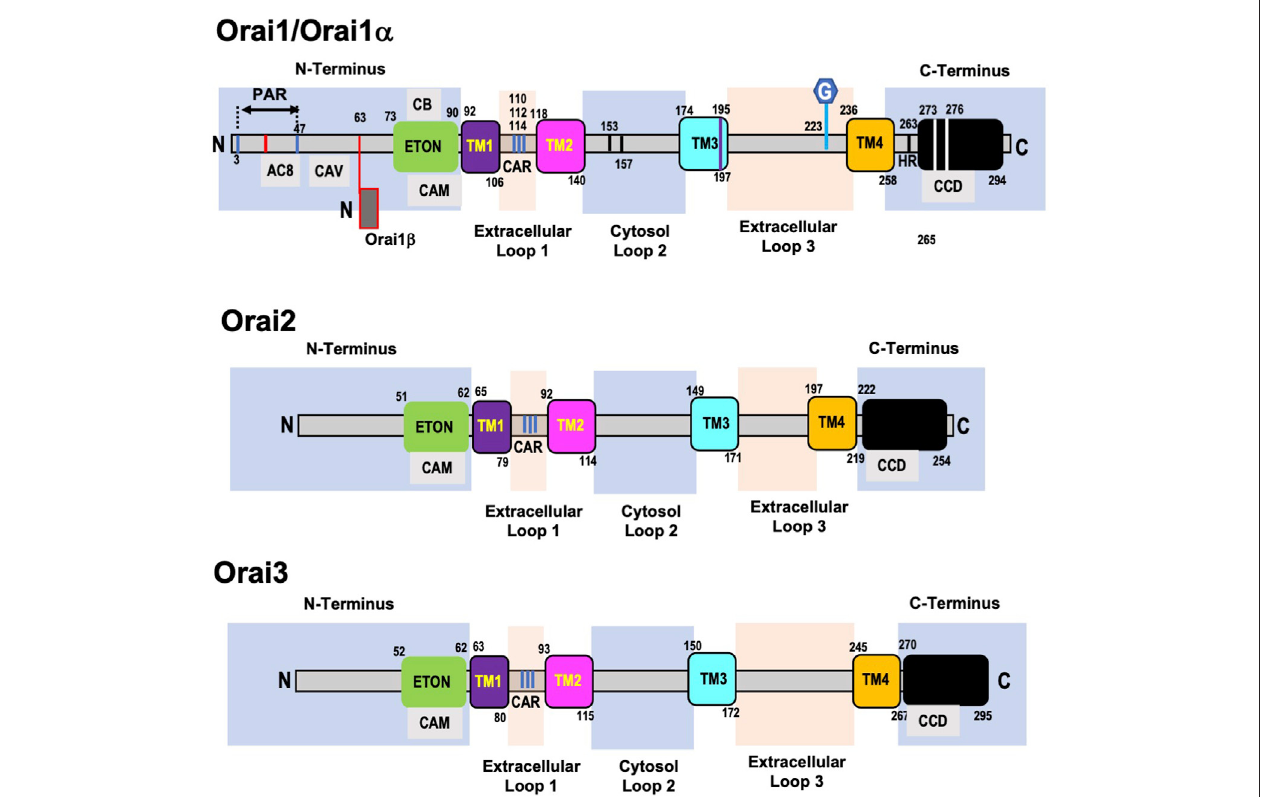
FIGURE 2 | Domain structure of human ORAI1, ORAI2, and ORAI3 proteins. Orai1 (Orai1 α ) has a proline arginine region (PAR) close to the end of the N-terminal domain,whichincludesaninteracting siteforadenylatecyclase-8 (AC8).Thisisfollowedbyacaveolin bindingregion(CAV)andadjacent totheplasmamembraneisthe Extended Transmembrane Orai1 N-terminal (ETON) region, which contains calmodulin (CAM) and cholesterol binding (CB) domains. Following the fi rst transmembrane domain (TM1) is the fi rst extracellular loop, which includes a Ca 2+ accumulating region (CAR). A region in the intracellular loop 2 — 153 – 157 — is thought to regulate Ca 2+ dependent inactivation ofOrai1and interaction between loop2and theETON regionregulatechannel activation.Acysteine residue (Cys195) attheend ofthethird transmembrane domain (TM3) has been implicated in the redox regulation of Orai1 function. The second extracellular loop (loop3) contains a N-glycosylation site at N223, of unknown function. The cytosolic C-terminus of Orai1 is connected to the 4th transmembrane domain (TM4) via a highly conserved hinge region (HR) and contains highly conserved coiled-coil domain (CCD). The C-terminal region essential for recruiting STIM1 and Orai1 channel activation. Alternative translation initiation results in Orai1 β which lacks the fi rst 63 amino acids of Orai1/Orai1 α . The architecture of Orai2 and Orai3 are very similar to Orai1 with a few key differences. Orai2 and Orai3haveatruncatedN-terminalregionwhichlacksthePARpresentinOrai1.Theyalsolackan18aaregionintheN-terminuswhichregulatestheslowreactivationthat follows fast CDI in Orai1. Similar to Orai1 both Orai2 and Orai3 contain ETON region adjacent to the TM1, which includes a CAM domain. The TM1 domains are almost completelyconserved,andtheother3transmembranedomainsexhibitahighlevelofhomologyacrossallOraiisoforms.However,Orai2and3lackthecysteineresidue in TM3 and the N-glycosylated site on extracellular loop 3 which are present in Orai1. Orai3 has a much longer loop 3 compared to both Orai1 and Orai2, but like Orai1, Orai2, and Orai3 also have coiled-coil domains their C-terminal regions.